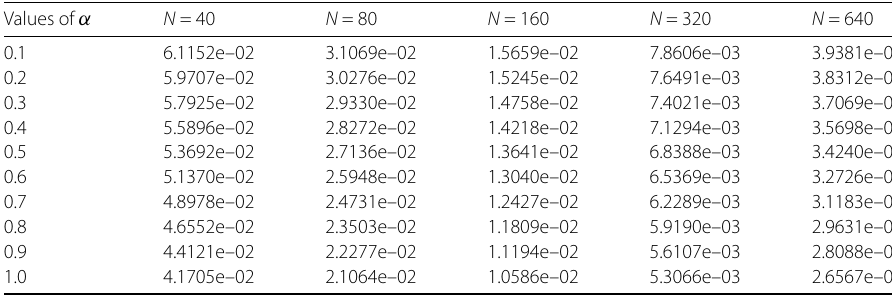
Table 1 Maximum absolute errors for Example 5.1 with r = 0.055 and δ = 0.065 Values of α N = 40 N = 80 N = 160 N = 320 N = 640 0.1